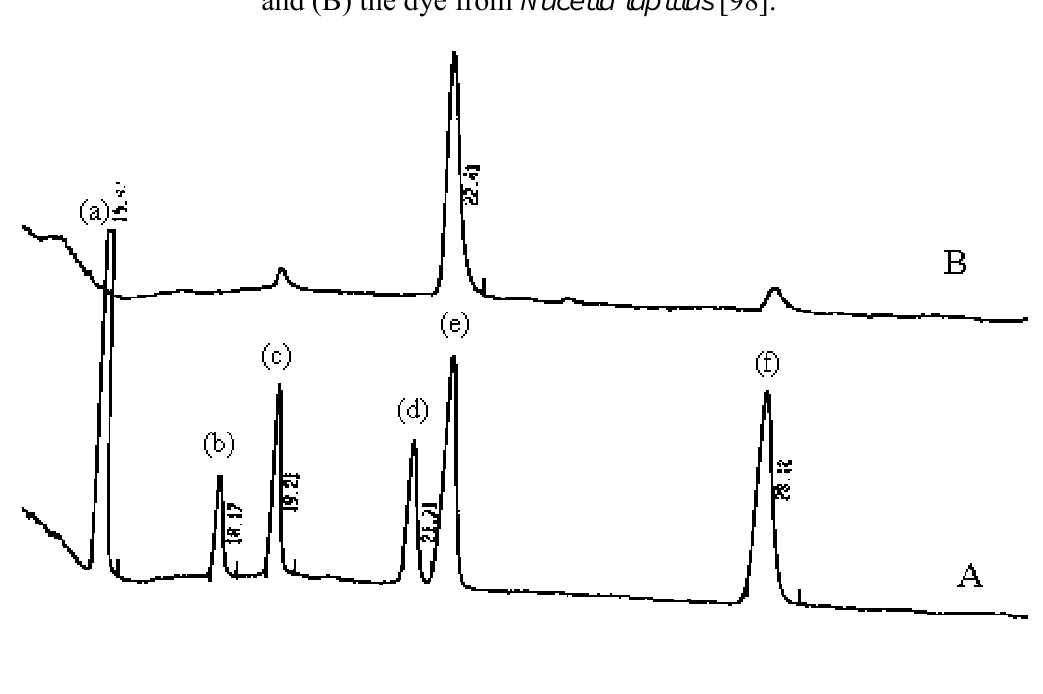
Figure 8. HPLC of (A) a mixture of (a) indigo, (b) indirubin, (c) 6-bromoindigo, (d) 6-bromoindirubin, (e) 6,6'-dibromoindigo and (f) 6,6'-dibromoindirubin, with retention times (minutes) and (B) the dye from Nucella lapillus [98].